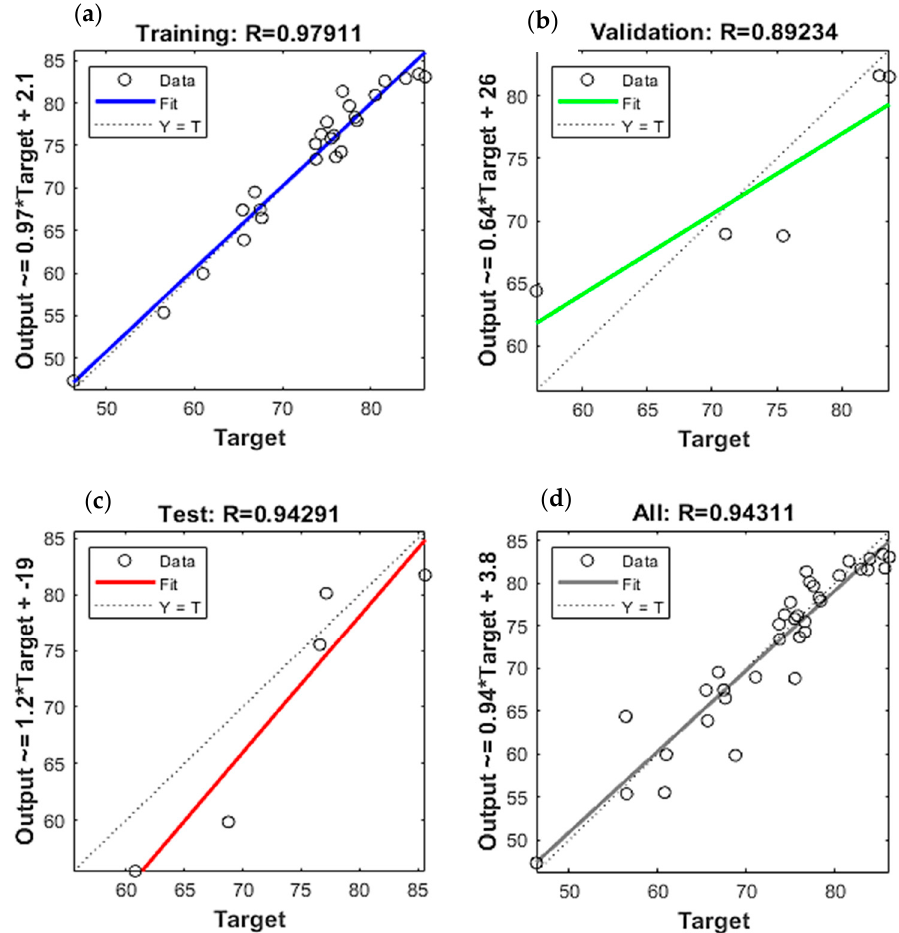
Figure 12. Comparison of predicted and observed WQI values during ( a ) training, ( b ) validation, and ( c ) testing phases ( d ) all during the dry season.